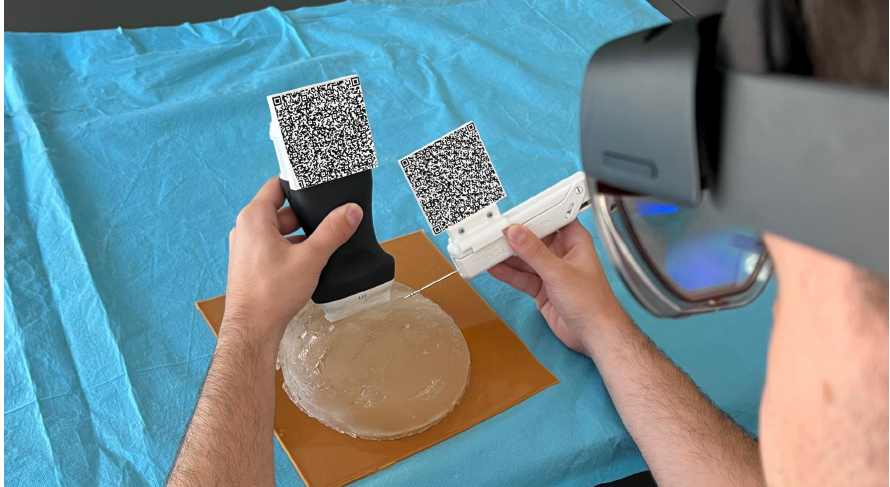
Figure 8. Third-person usability test view of a user performing the biopsy in a breast